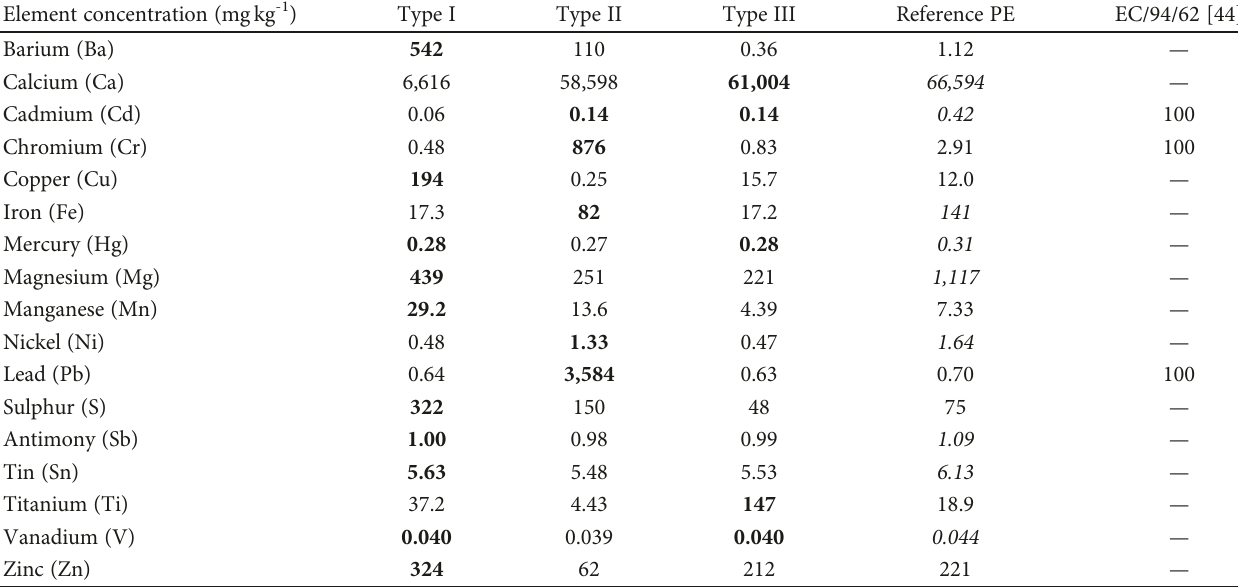
Table 2: Trace metal analysis for the oxo-biodegradable bags tested. Element concentration (mgkg -1